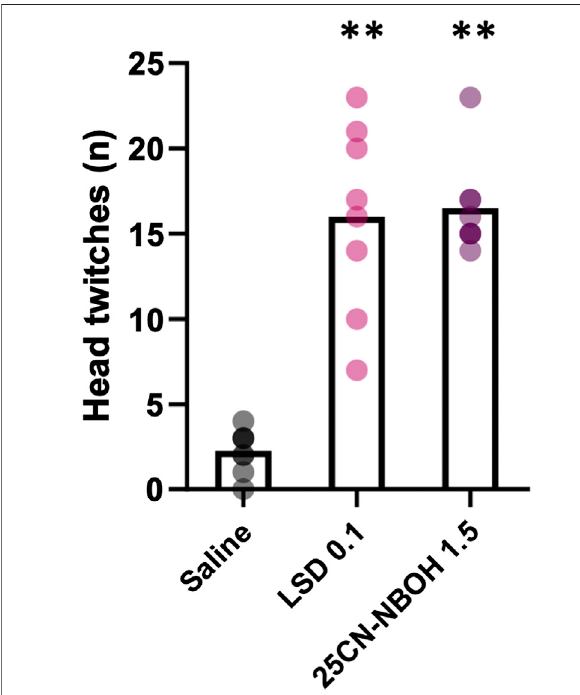
FIGURE 1 | Number of head twitch responses observed during the fi rst 10 min after administration of saline, 0.1 mg/kg LSD, and 1.5 mg/kg 25CN- NBOH (repeated administration, n (cid:1) 8). The data are shown as means with individual values depicted by the dots. Statistically signi fi cant differences in comparison to saline shown as ** p < 0.01.